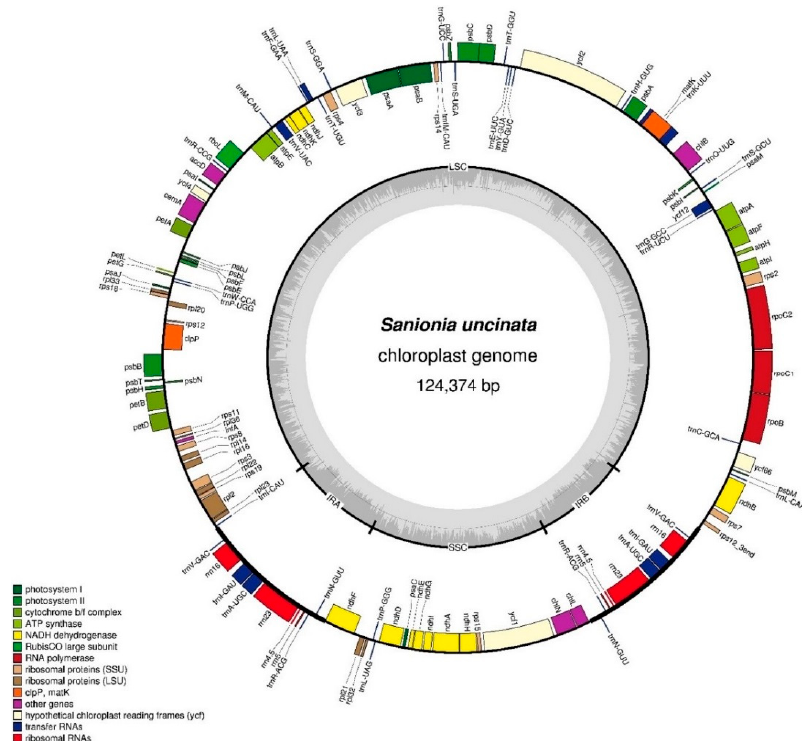
Figure 1. Map of the Sanionia uncinata plastome. Complete plastome sequences were obtained from the de novo assembly of Illumina paired-end reads. Genes are color coded by functional group, which are located in the left box. The inner darker gray circle indicates the GC content while the lighter gray corresponds to AT content. IR, inverted repeat; LSC, large single copy region; SSC, small single copy region. Genes shown on the outside of the outer circle are transcribed clockwise and those on the inside counter clockwise. The map was made with OGDraw [31]. Table 1. Genes present in the S. uncinata plastome.